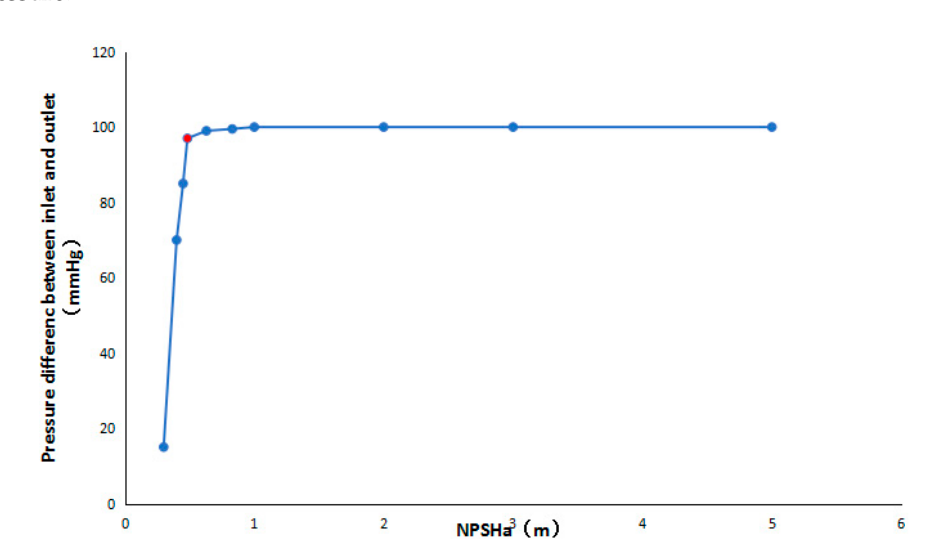
( c ) Figure 10. Cavitation bubbles in pump impellers at different inlet pressures: ( a ) Pin = 11 kPa; ( b ) Pin = 10 kPa; ( c ) Pin = 9 kPa. Figure 11 shows an isosurface with a flow volume of 5 L/min and an air bubble volume of 0.1 in